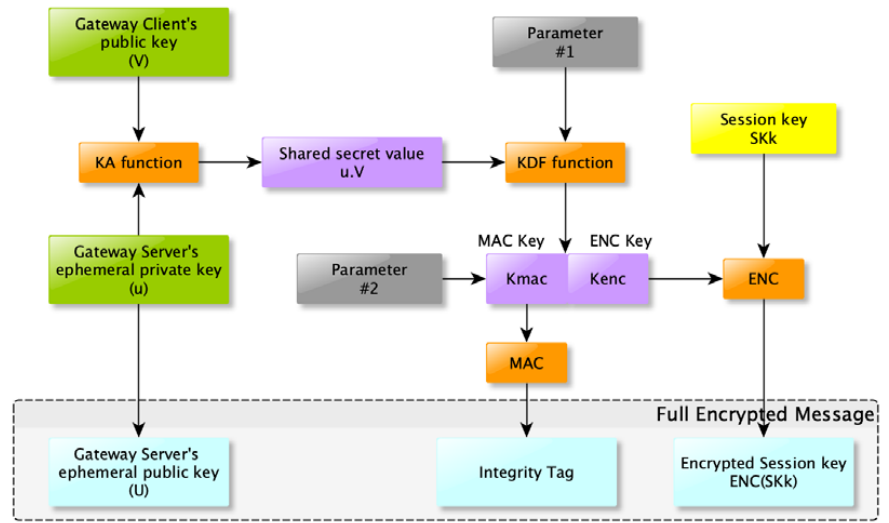
Figure 3. Scheme used to encrypt a session key.